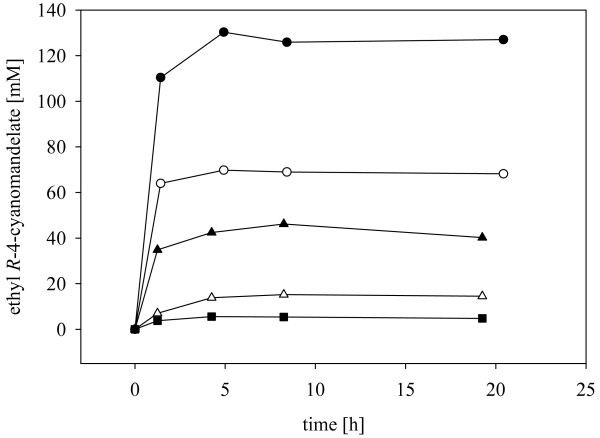
Whole cell-catalyzed reduction of ethyl 4-cyanobenzoylformate by E. coli XR_FDH. The analytical yield is given and expressed as concentration of ethyl 4-cyanomandelate formed from the initial substrate concentration. Conditions are indicated by symbols: ● [substrate] = 500 mM, [cells] = 40 gCDW/L; ○ [substrate] = 100 mM, [cells] = 40 gCDW/L; ▲ [substrate] = 100 mM, [cells] = 20 gCDW/L; Δ [substrate] = 100 mM, [cells] = 5 gCDW/L; ■ [substrate] = 10 mM, [cells] = 5 gCDW/L.